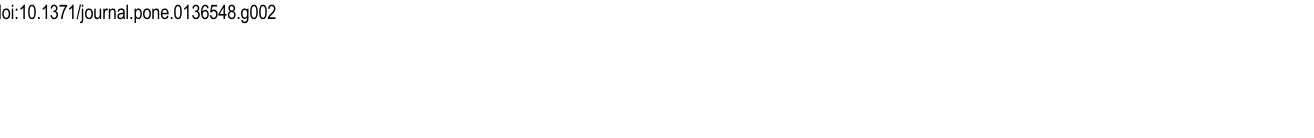
PLOS ONE | DOI:10.1371/journal.pone.0136548 August 25,